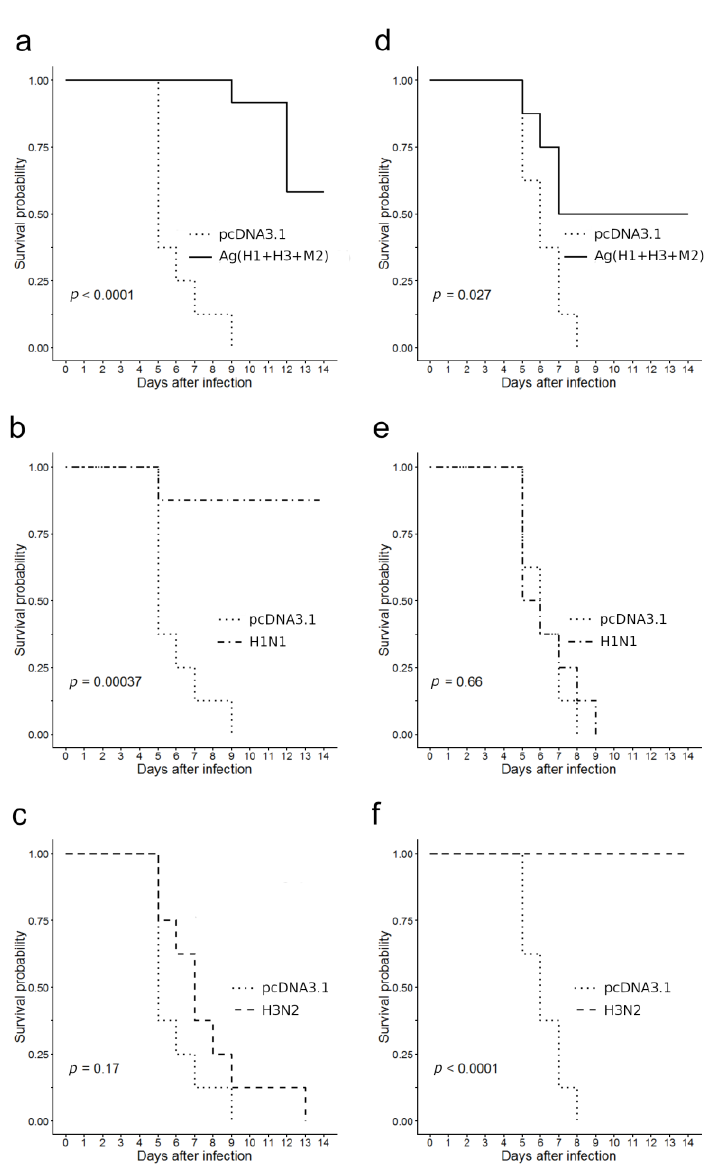
Figure 6. Immunized mice survival after a lethal challenge with pathogenic influenza A viruses in comparison to that of the negative control (pcDNA3.1). ( a – c ) Infection with virus A/California/4/09 (H1N1pdm); ( d – f ) infection with virus A/Aichi/2/68 (H3N2); ( a , d ) DNA vaccinated, ( b ) and ( e ) H1N1 vaccinated, and ( c , f ) H3N2 vaccinated.